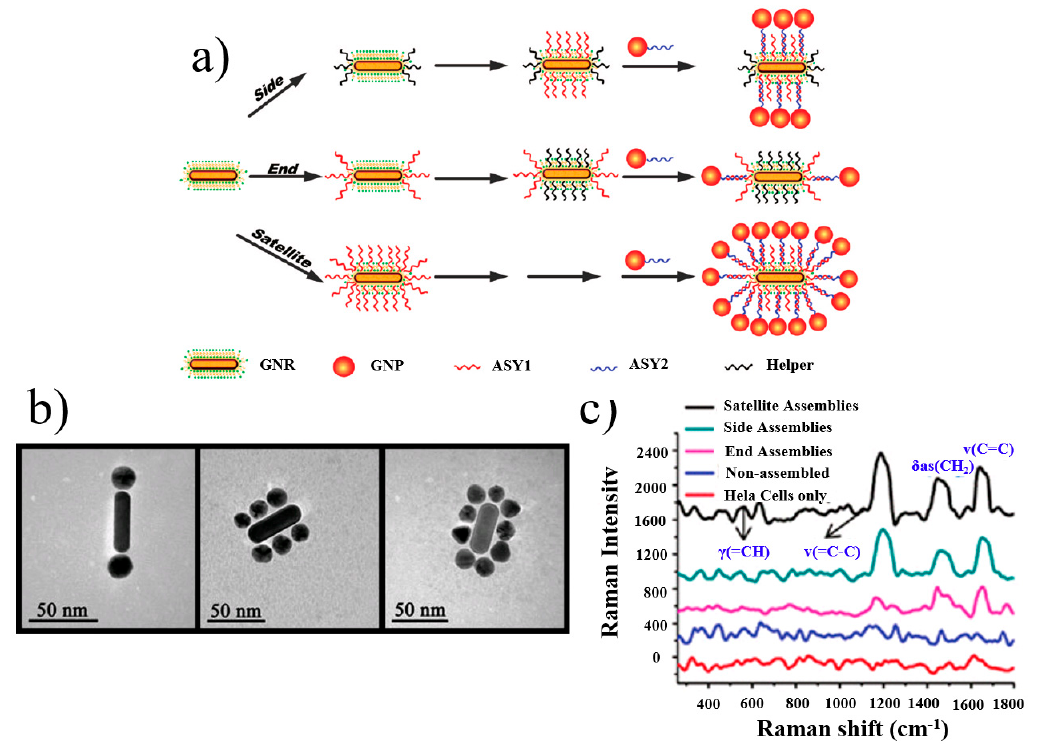
Figure 40. ( a ) Schematics of three types of NP assemblies. ( b ) Typical TEM images. ( c ) Raman spectra of three types of assemblies [157].